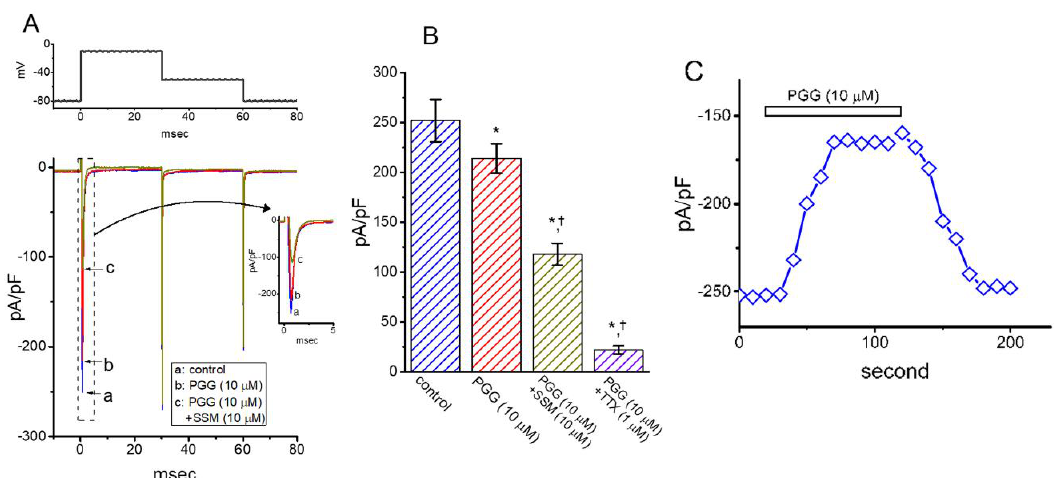
Figure 8. Inhibitory e ff ect of PGG on the density of voltage-gated Na + current ( I Na ) in GH 3 cells. The experiments were conducted in cells kept to be bathed in Ca 2 + -free Tyrode’s solution containing 10 mM tetraethylammonium chloride and 0.5 mM CdCl 2 , and we filled up the recording electrode by using Cs + -containing solution. ( A ) Representative I Na densities obtained in the control (a) and during the exposure to 10 µ M PGG (b) or 10 µ M PGG plus 10 µ M sesamin (SSM) (c). The voltage protocol delivered is presented in the upper part, while inset indicates an expanded record from the dashed box. Of note, the voltage-clamp profile used in the present study was applied to measure transient and deactivating densities of I Na . ( B ) Summary bar graph revealing e ff ects of PGG, PGG plus sesamin (SSM), and PGG plus tetrodotoxin (TTX) on the density of depolarization-evoked I Na (mean ± SEM; n = 8). The density of peak I Na was taken at the start of brief depolarization from − 80 to − 10 mV. The statistical analyses were done by ANOVA-1, p < 0.05, followed by post-hoc Fisher’s least-significant di ff erence test, p < 0.05. * indicates a significant di ff erence from control ( p < 0.05), and † significantly di ff erent from PGG (10 µ M) alone group ( p < 0.05). ( C ) Time course showing the e ff ect of PGG (10 µ